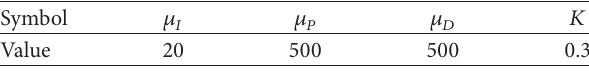
Table 3: Control parameters for emergency